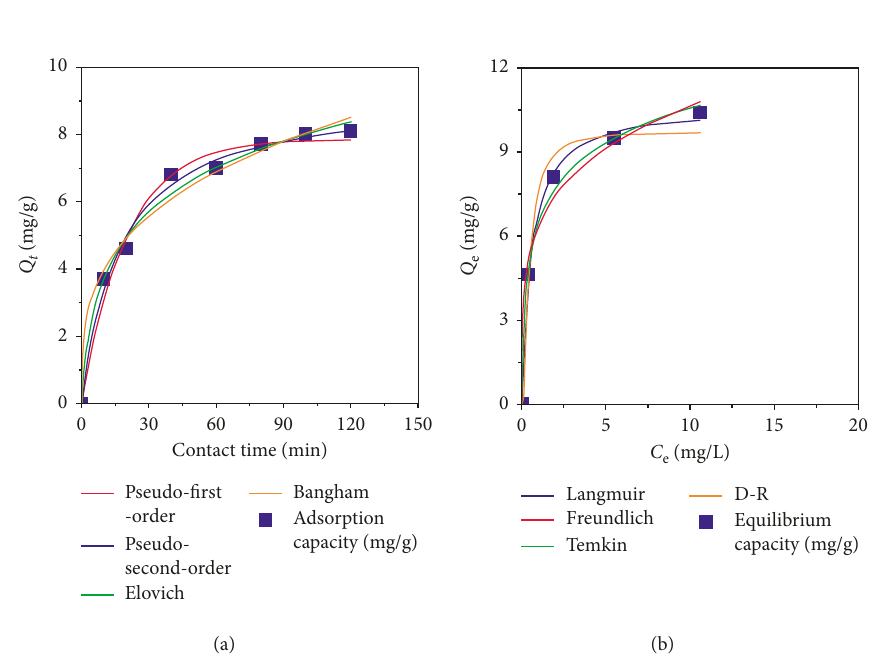
Figure 7: Kinetic and isotherm models for adsorption of IBU onto MIL-53(Fe). Experimental conditions consisted of initial concentration (10mg/L), dosage (1.0 g/L), and pH 2.6 at room